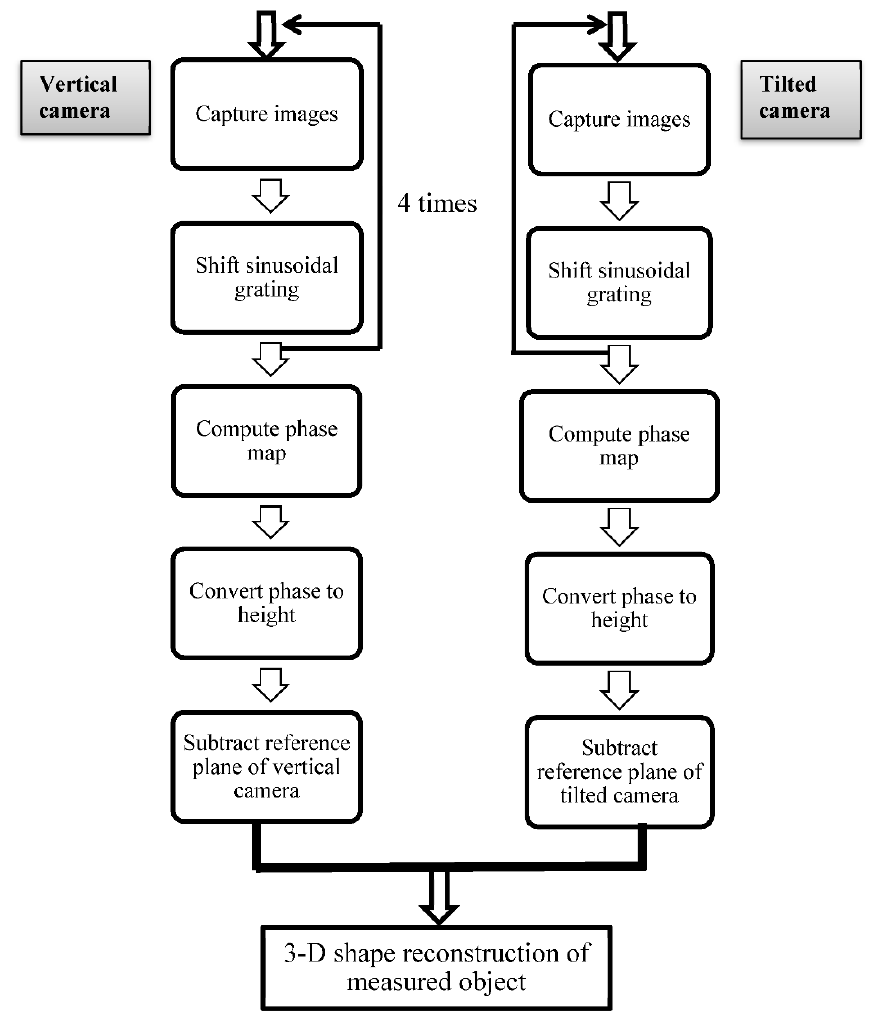
Figure 5. Flowchart of the proposed calibration procedure.